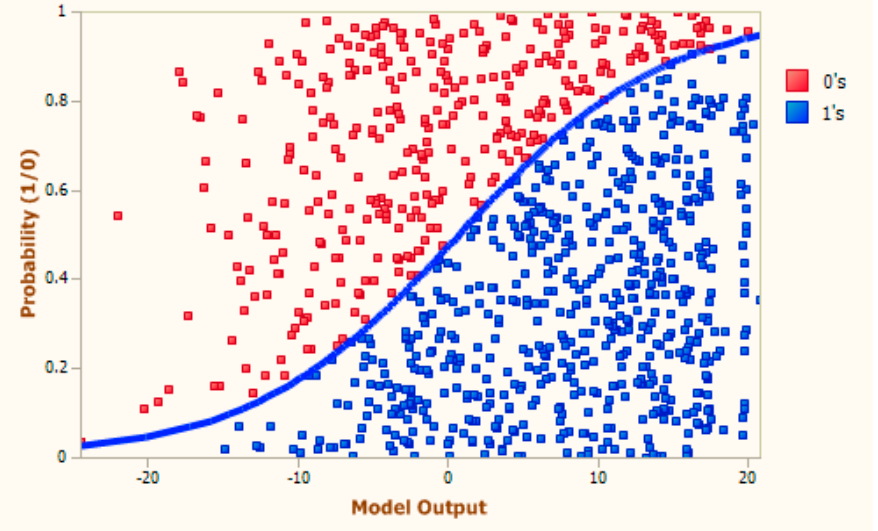
Figure 10. LRA Classification Diagram [21].